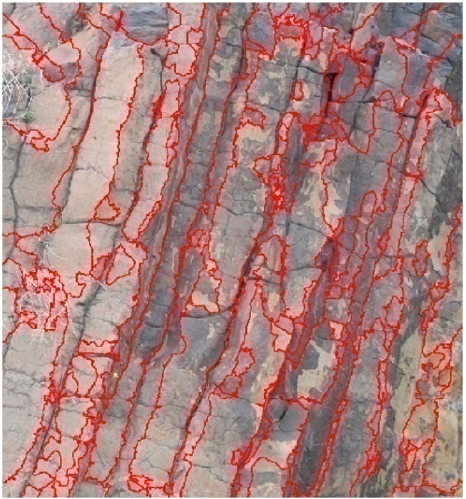
Figure 22. The clustering result of superpixels for the test image.